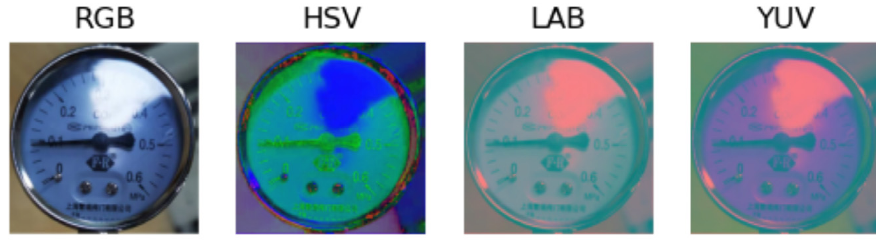
Figure 7. Color model comparison.